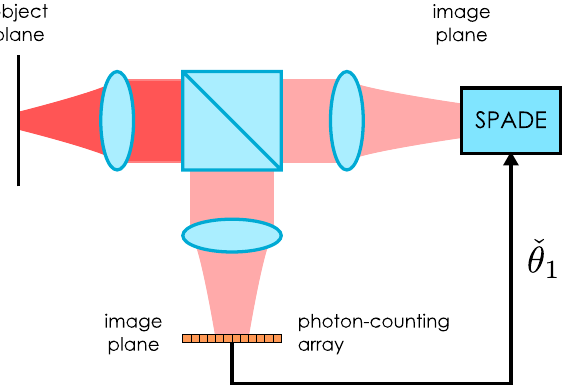
FIG. 10. A hybrid measurement scheme that splits the optical field by a beam splitter, measures one output port by a photon- counting array, and uses the centroid estimate at the other